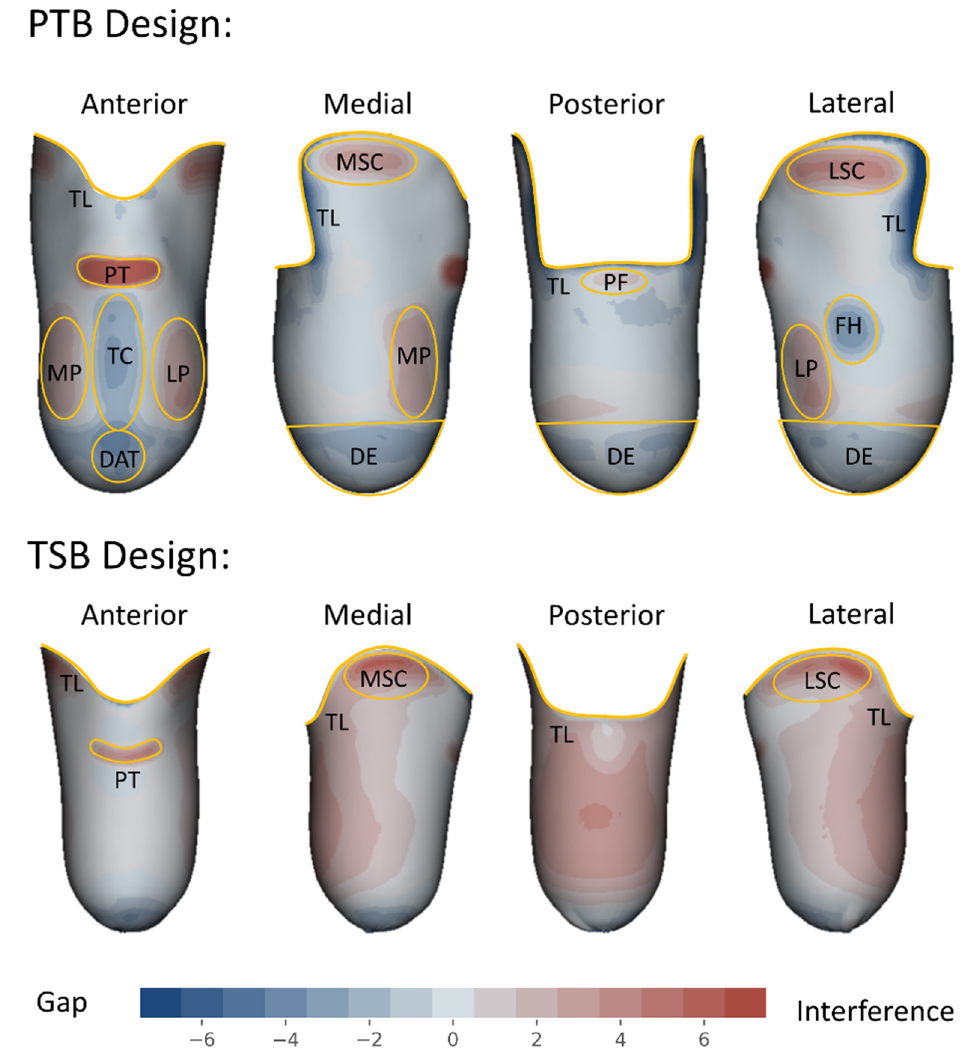
Figure 2. Example limb shapes plotted with rectification design field from aligned, registered sockets, of PTB (top) and TSB (bottom) design approaches. Rectifications are labelled as PT (patella tendon), TC (tibial crest), DAT (distal anterior tibia), DE (distal end), LP (lateral paratibial), MP (medial paratibial), FH (fibula head), MSC (medial supracondylar), LSC (lateral supracondylar), and PF (popliteal fossa). The images also label the trim line (TL).